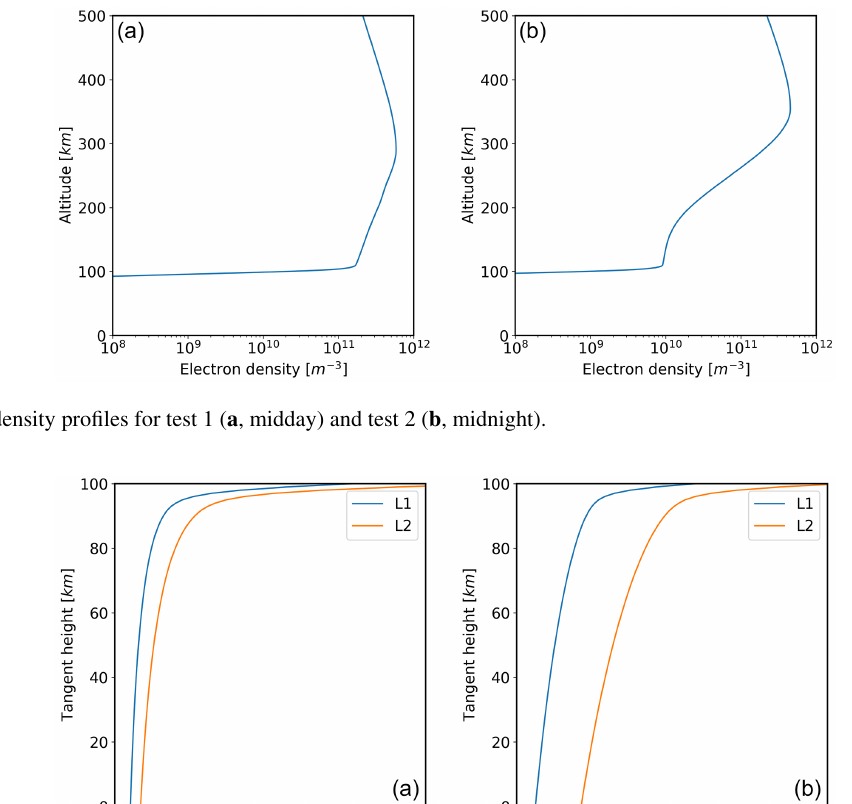
variant is used in the Galileo Global Navigation Satellite